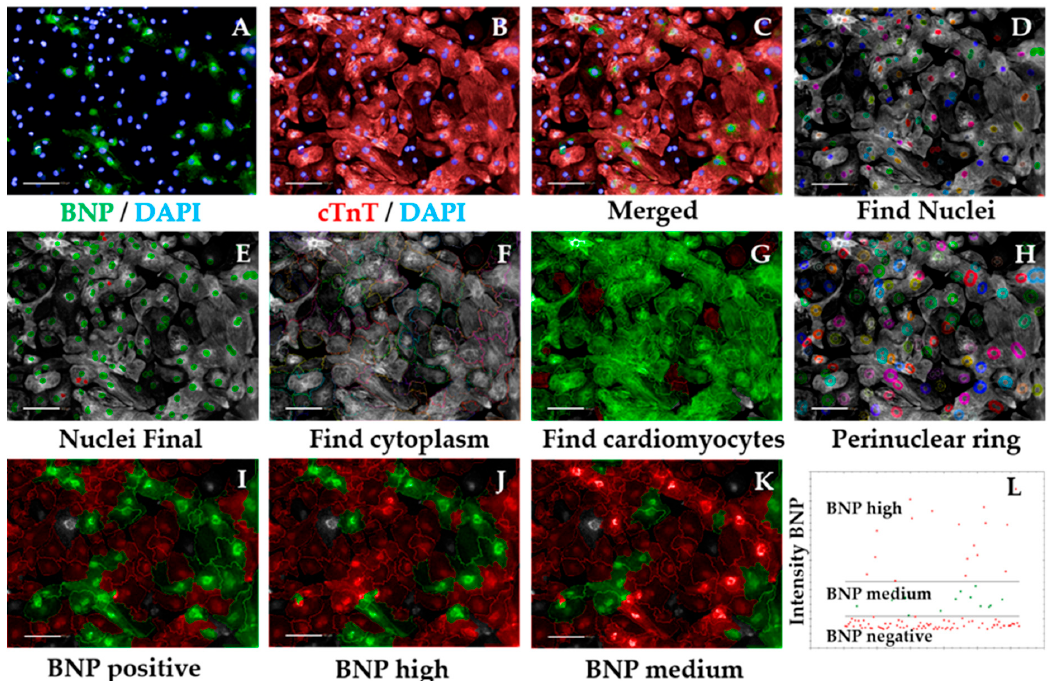
Figure 5. Hypertrophic marker BNP analysis sequence. Representative micrographs of image analysis of hPSC-CMs. After inputting the image ( A – C ), the software excludes debris and cell clumps ( D , E ) and uses the cardiac troponin T (cTnT) staining to define cell cytoplasm ( F ). The cTnT signal intensity is quantified and a positive signal threshold is determined by comparing with cell-type control enabling exclusion of non-cardiomyocytes from the analysis ( G ). A perinuclear ring is defined in cardiomyocytes ( H ) and BNP intensity is quantified in this region. Comparison of BNP signal intensity to that of ET1- or BOS-treated cardiomyocytes enables distinction between high vs. medium BNP-expressing cells